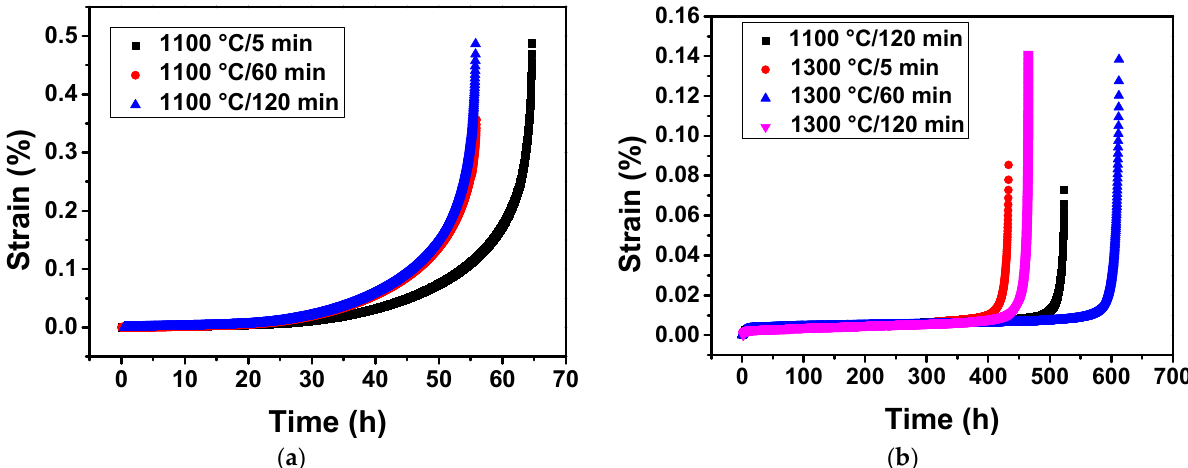
Figure 4. Curves of creep strain vs. time under creep condition 1000 °C/300 MPa for specimens overheated at 1100 °C/5 min, 1100 °C/60 min, and 1100 °C/120 min ( a ); under creep condition 1100 °C/130 MPa for specimens overheated at 1100 °C/120 min, 1300 °C/5 min, 1300 °C/60 min, and 1300 °C/120 min ( b ).